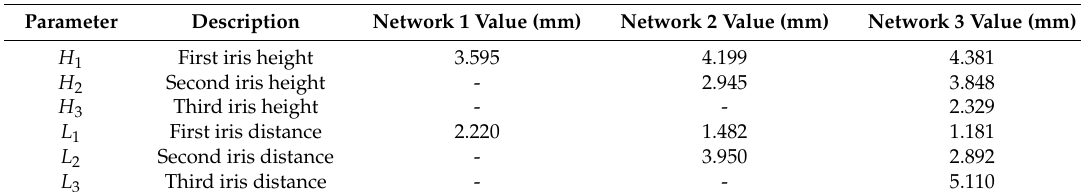
Table 4. Matching networks geometrical parameters.